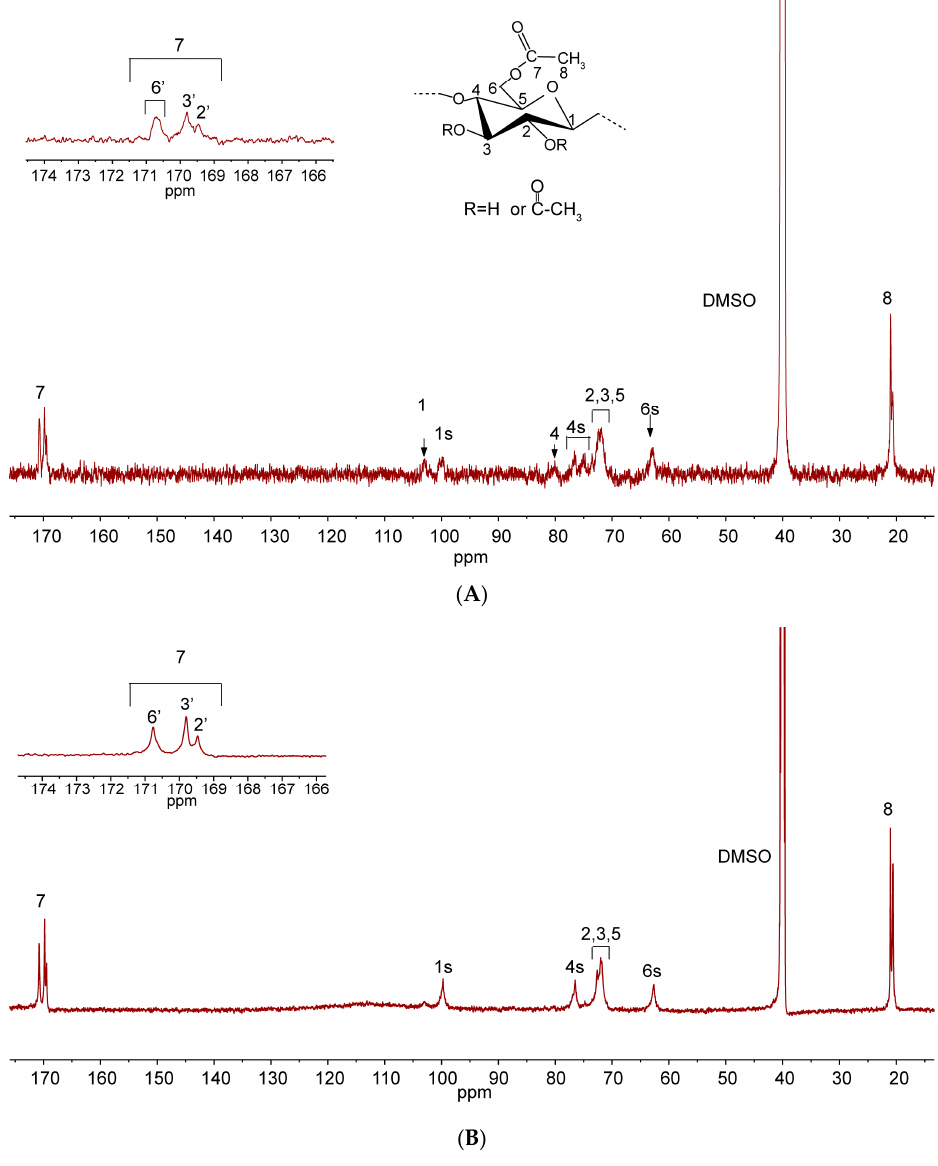
Figure 2. 13 C-NMR spectra of CA-3 (DS = 2.18, A ) and CA-17 (DS = 2.75, B ).